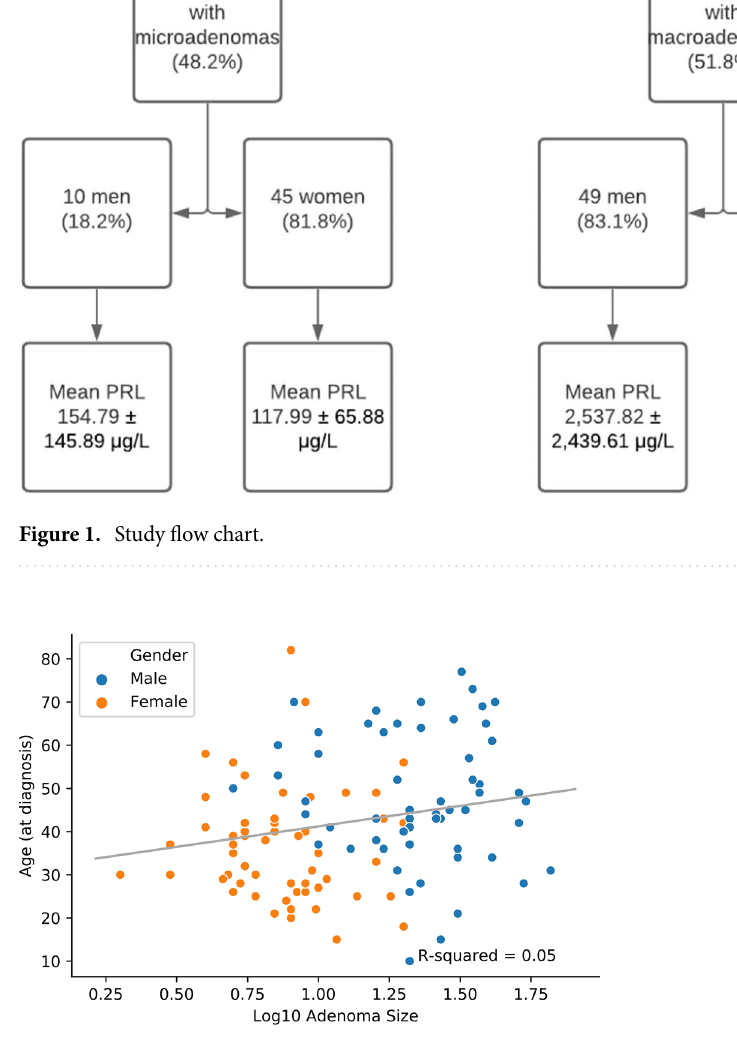
Figure 2. Correlation between age at diagnosis and adenoma size—grouped by